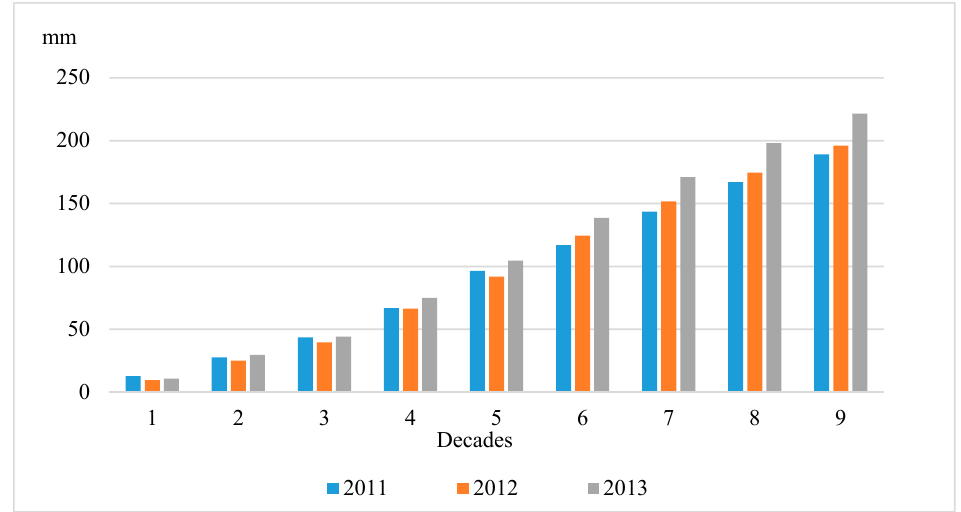
Figure 4. Cumulative water consumption (mm) of potato cultivar Courage determined directly according to Hargreaves DA ’s formulas for 9 decades of the period (June–August) in 2011–2013.